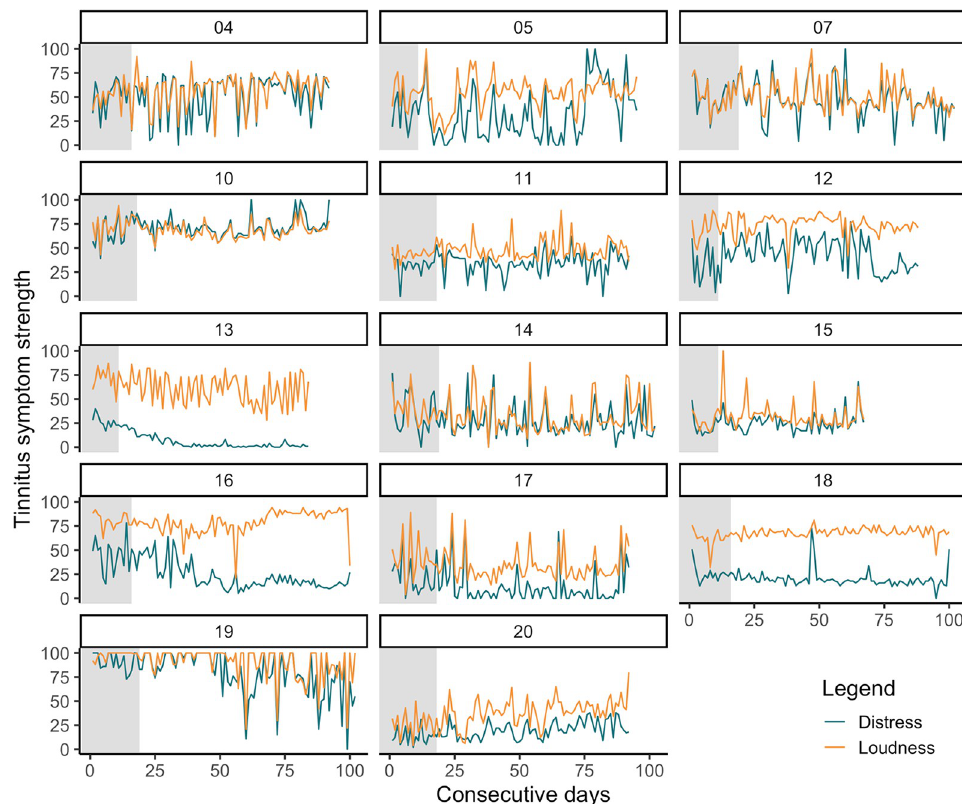
Fig 3. Course of tinnitus distress and loudness for each case (EMA). Individual courses of tinnitus symptoms that were assessed daily with Ecological Momentary Assessment over the study period. The grey area represents the baseline phase (EMA), the white area represents the intervention phase (EMA, structured counseling, sound therapy). Distress: How burdensome do you find your tinnitus at the moment? (0 not burdensome– 100 very burdensome); Loudness: How loud is your tinnitus at the moment? (0 inaudible– 100 very loud). N =